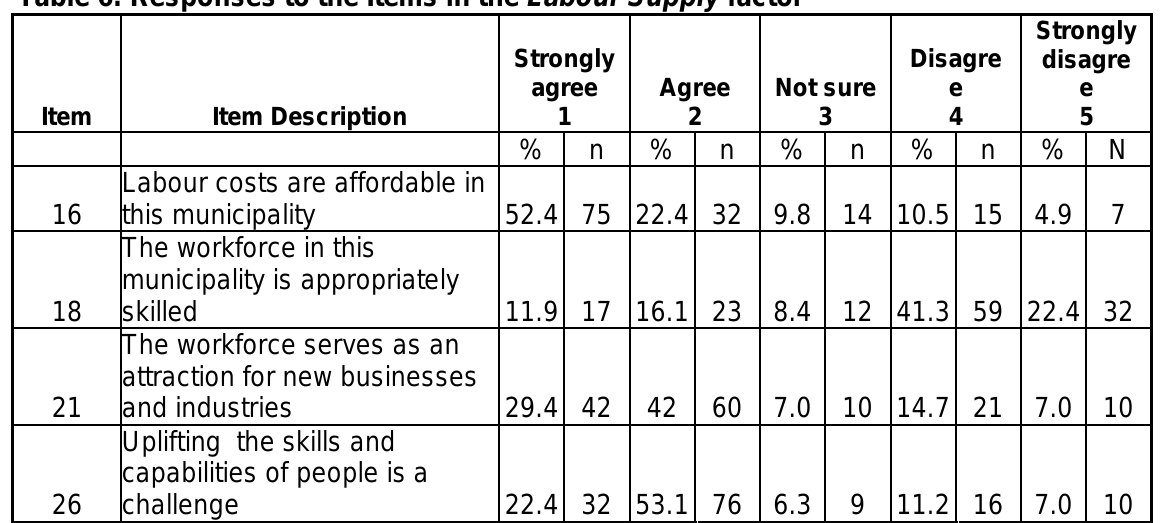
Table 6: Responses to the Items in the Labour Supply factor